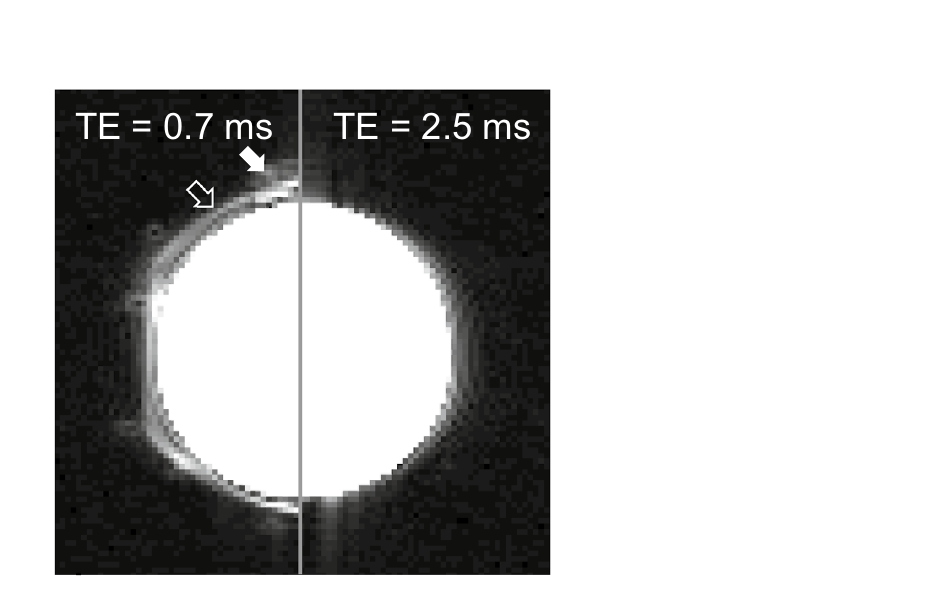
Figure 10. The six-channel cable array included MR-visible components. ABS plastic clamps (solid arrow) and foam cushioning (open arrow) were visible in an image acquired with TE = 0.7 ms (left). The components were not visible with TE = 2.5 ms